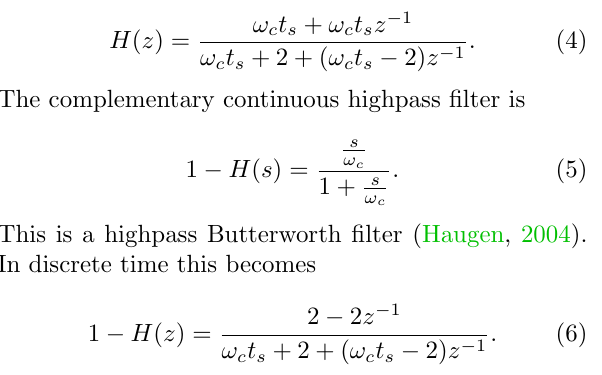
Figure 6. In other words: The cut-off frequency will be chosen to attenuate the data shown in Figure